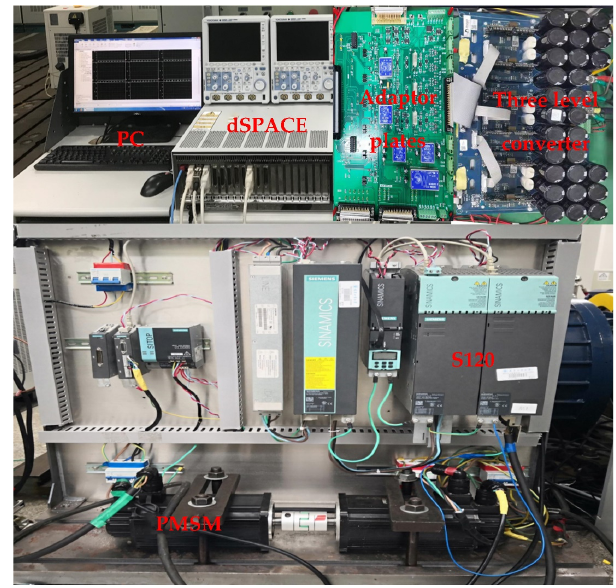
Figure 7. Experimental prototype. Table 5. Rated parameters of PMSM.